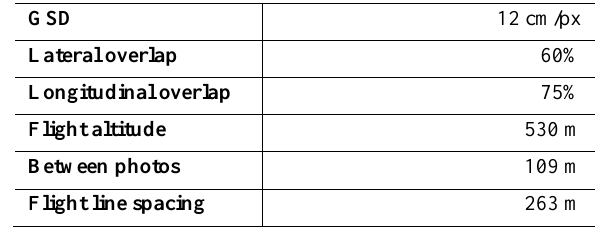
Table 2. Summary of flight plan